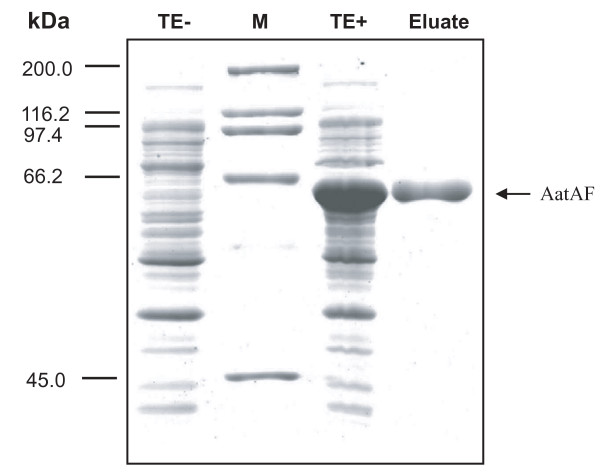
Purification of AatAF after expression in E. coli BL21. The internal part of aatA encoding the passenger domain of AatA was cloned into pET32a(+) leading to the expression of the 64-kDa fusion protein AatAF. BL21 cells were incubated in LB at 37°C without (lane 1) or with (lane 3) addition of IPTG. Proteins of total extracts (lane 1 and 3) and of eluates of the purified AatAF (lane 4) were separated on an SDS-PAGE and stained with coomassie. TE: total extract, -: without IPTG, +: with IPTG; M: protein marker.